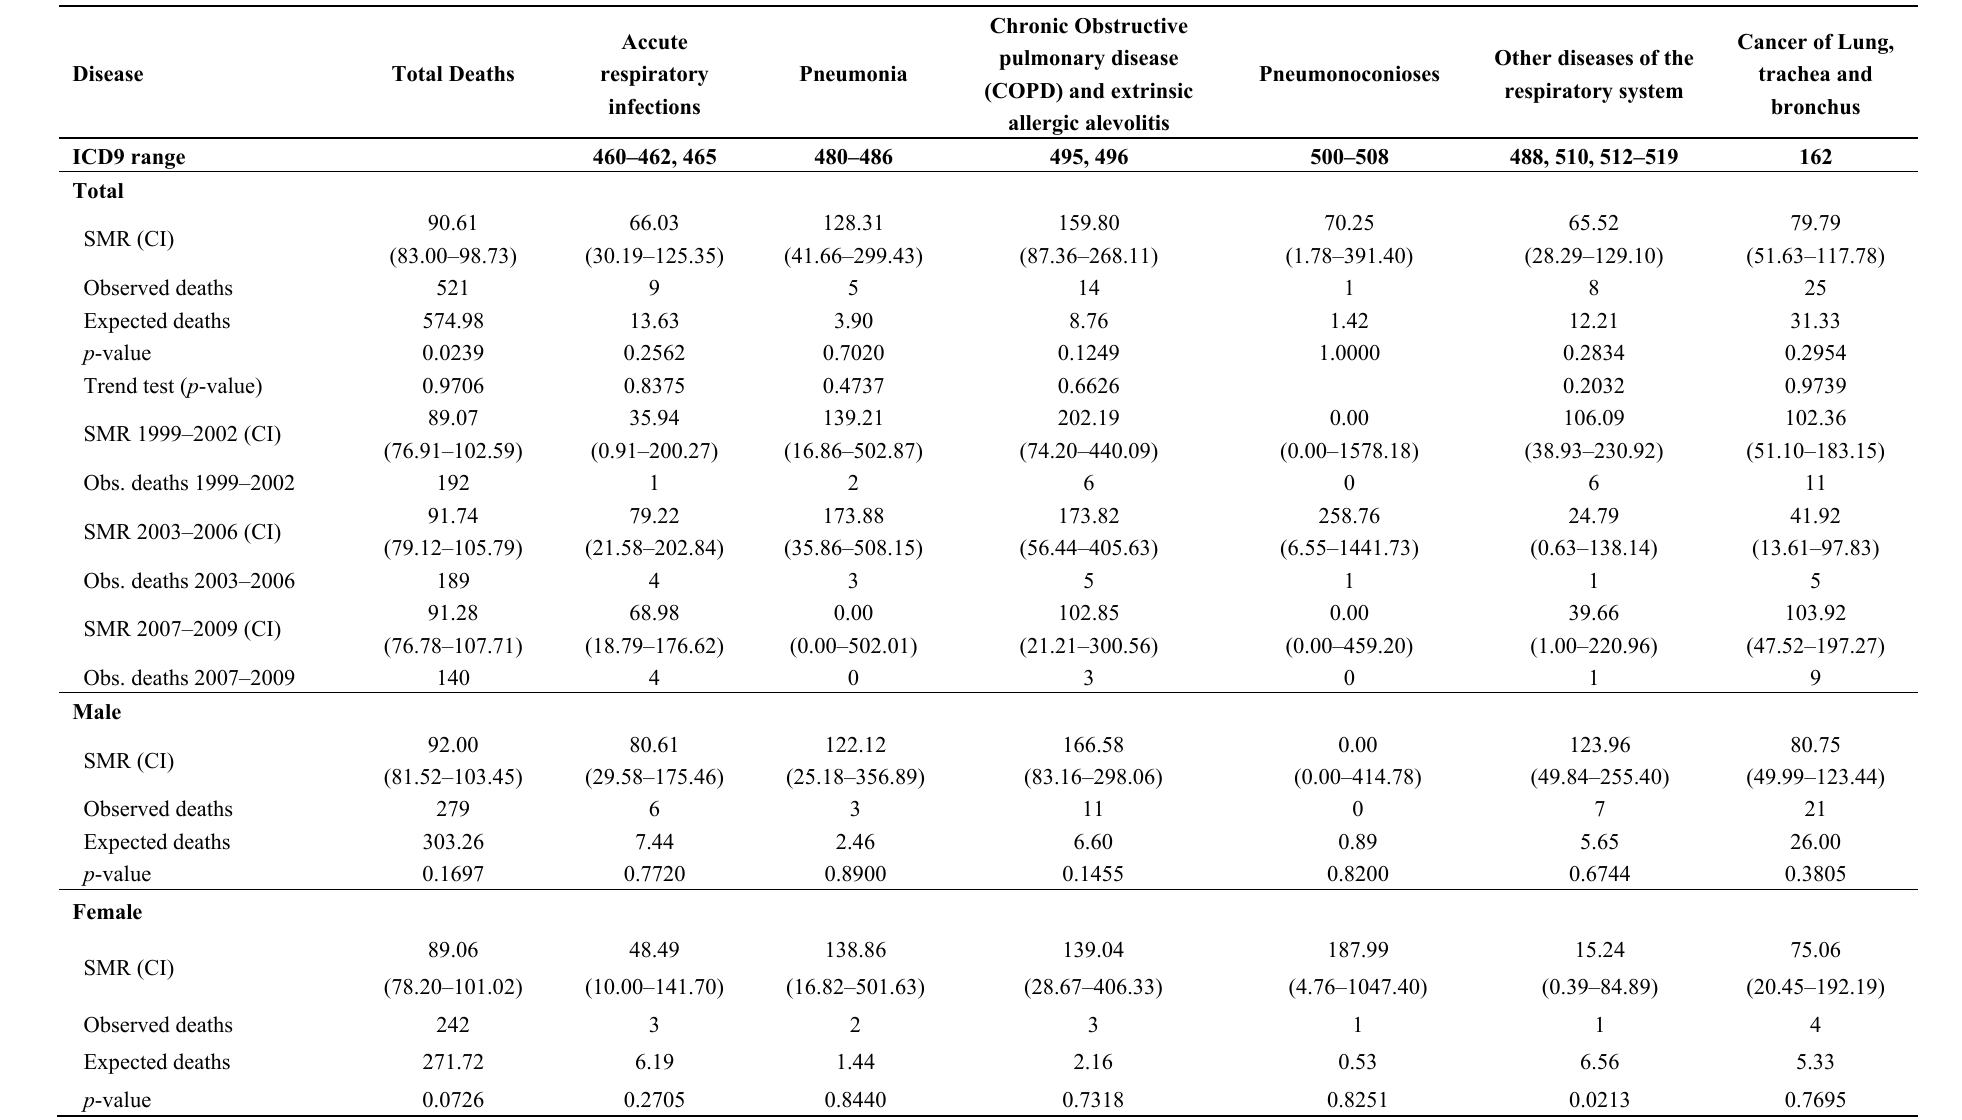
Table 1. Mortality in Milos compared to Cyclades prefecture for specific respiratory diseases; years